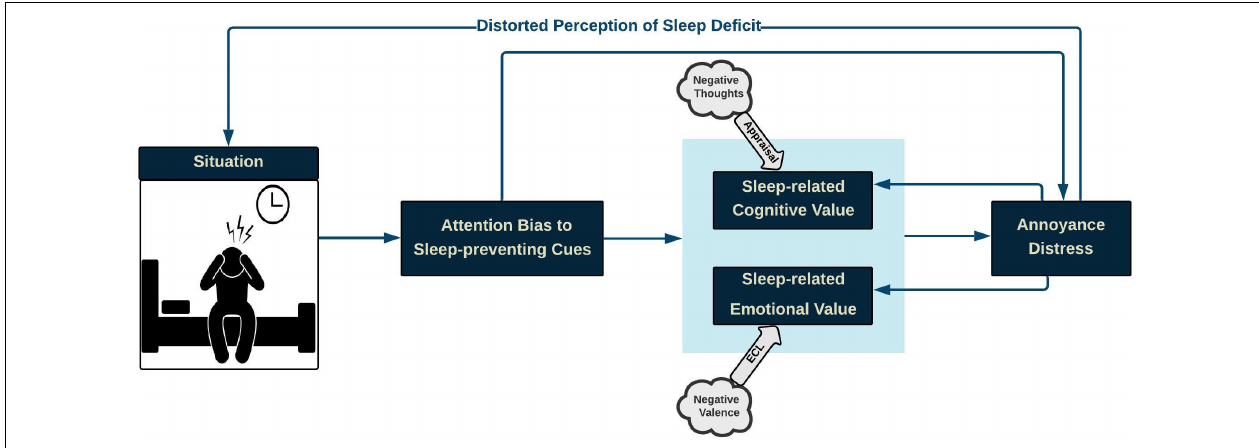
FIGURE 1 | Conceptual Cognitive Framework of Insomnia: During the pre-sleep situation, when attentional resources are captured by insomnia-related stimuli, either directly or through insomnia-related cognitive and emotional values, distress is triggered, thus resulting in a distorted perception of sleep quality, which, in turn, worsens the sleep-initiation process. Likewise, insomnia distress strengthens the negative cognitive-emotional value of difficulty in